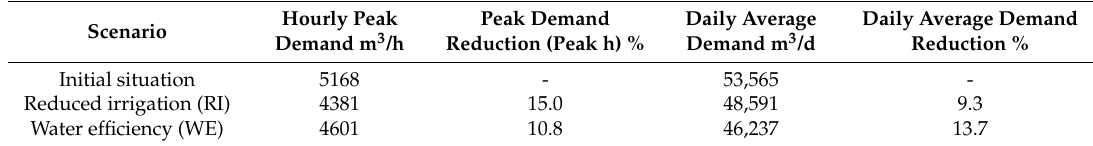
Table 1. Summary of the scenarios and simulated the demand